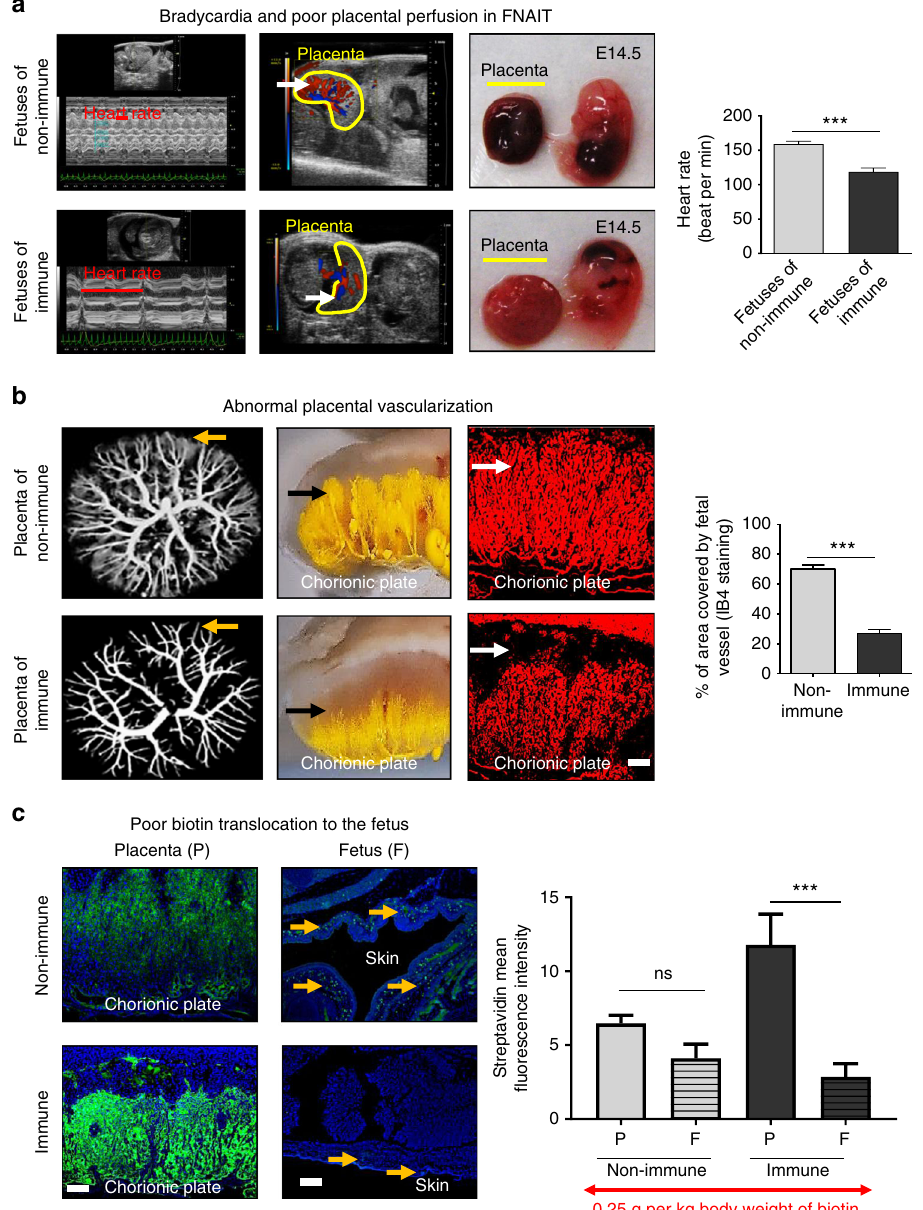
Fig. 2 Abnormal placental vascularization and poor placental perfusion. a Bradycardia, impaired intraplacental blood fl ow ( white arrow for Doppler waveforms) and poor placental blood perfusion ( gross picture s) were found in FNAIT fetuses compared to fetuses of non-immune mice at E14.5. b Placental casts of the umbilical arterial circulation showed poor development of fetal capillaries in the labyrinth of placentas of immune mice as revealed by microtomography scan, stereomicroscopy micrograph, and IB4 immunostaining. c Fifteen minutes after maternal intravenous biotin injection, biotin transportation across the placenta into the fetal tissues (indicated by yellow arrows ) was much more limited in fetuses from immune than control mice. Data were collected from more than eight pregnancies per group. Unpaired Student ’ s t -test. Mean ± SEM. *** p < 0.001 and ns not signi fi cant. Scale bars